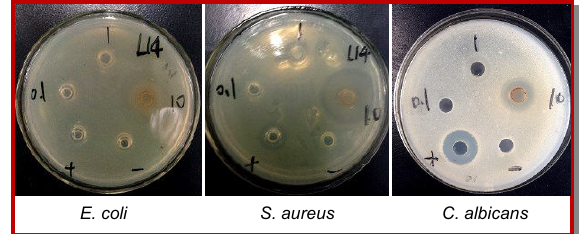
E. Figure 2: Antimicrobial effects of ethyl acetate extract of fungal strain L14